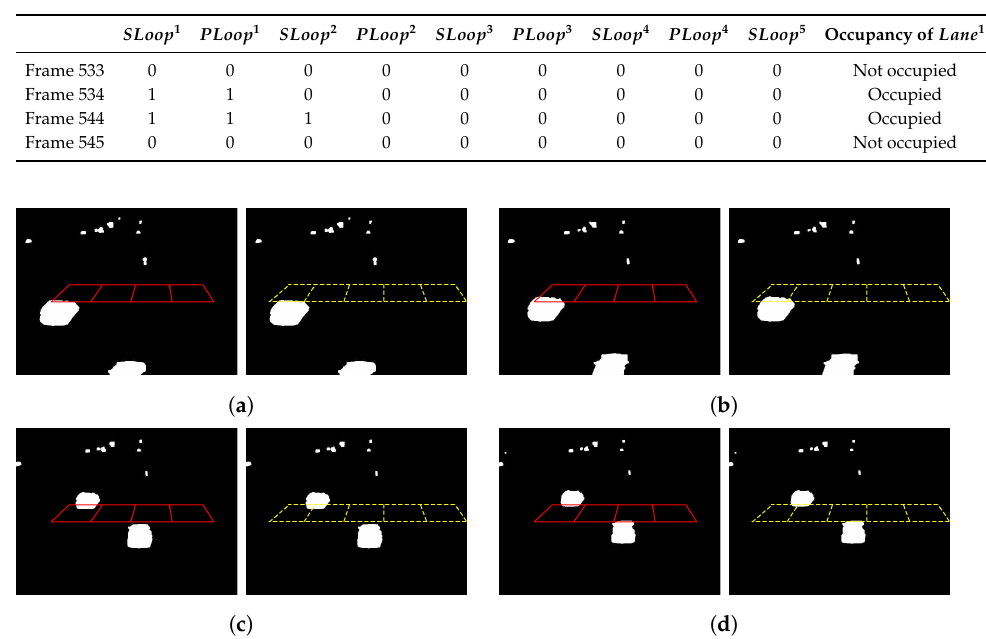
Figure 14. Four key frames of the left black vehicle in Figure 2a. ( a ) Frame 533 ( Lane 1 is not occupied). ( b ) Frame 534 ( Lane 1 is occupied). ( c ) Frame 544 ( Lane 1 is occupied). ( d ) Frame 545 ( Lane 1 is not